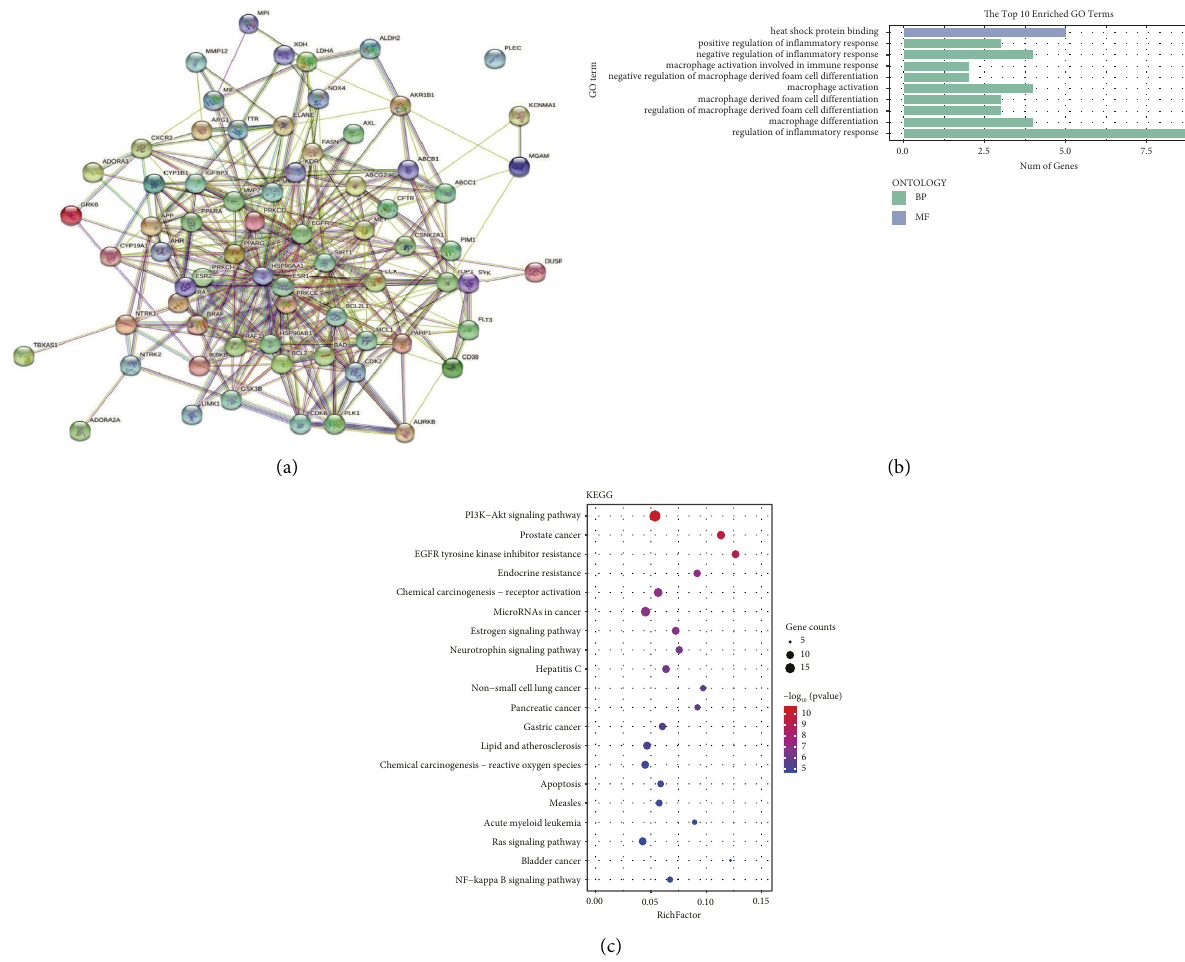
Figure 1: Results of network pharmacology analysis. (a) GO enrichment analysis; (b) PPI network diagram; and (c) KEGG enrichment